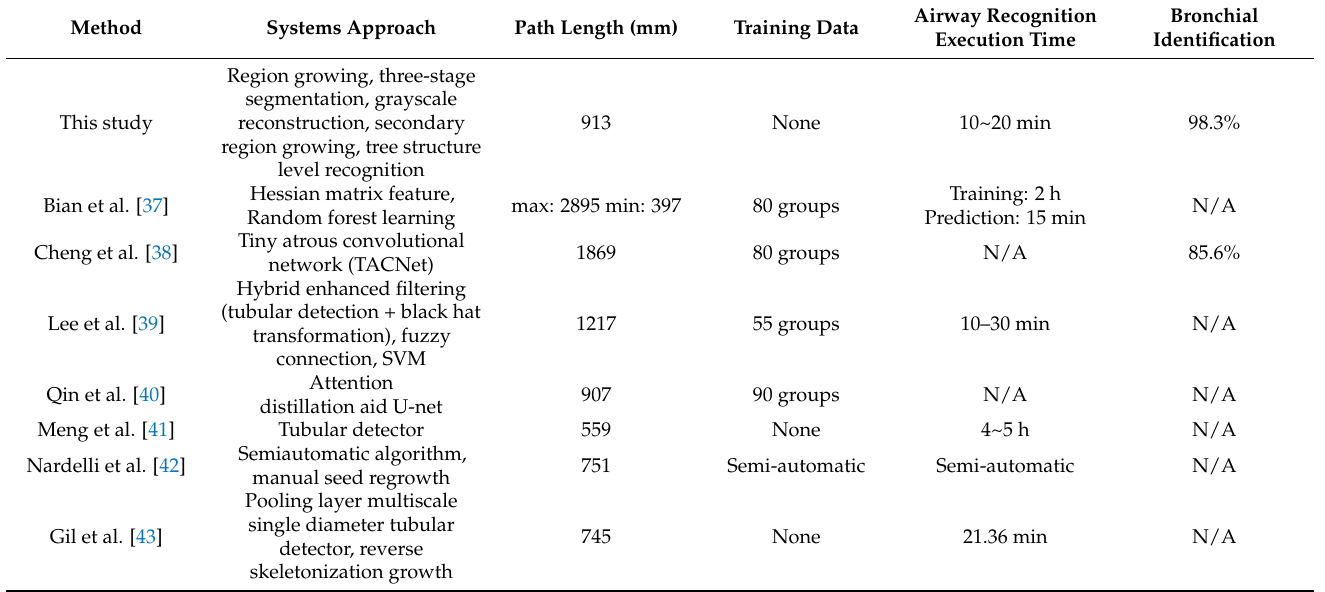
Table 4. Application, systems approach, and effect of bronchial identification